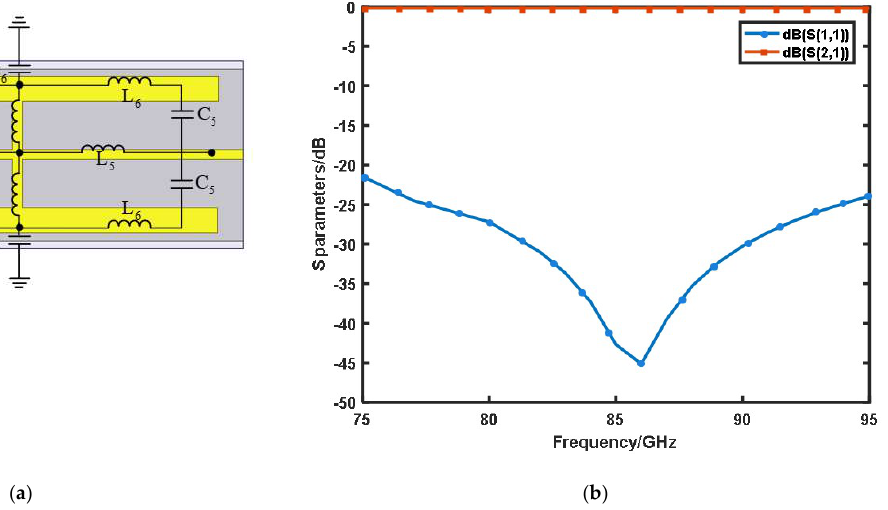
Figure 2. ( a ) DC filter structure; ( b ) simulation results of the DC filter (S11 > 21 dB, S21 < 0.2 dB at 75–95